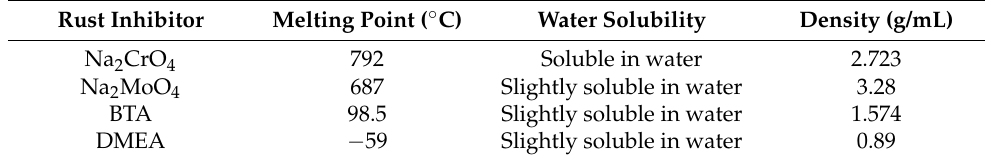
Table 2. Physical property index of the rust inhibitors.